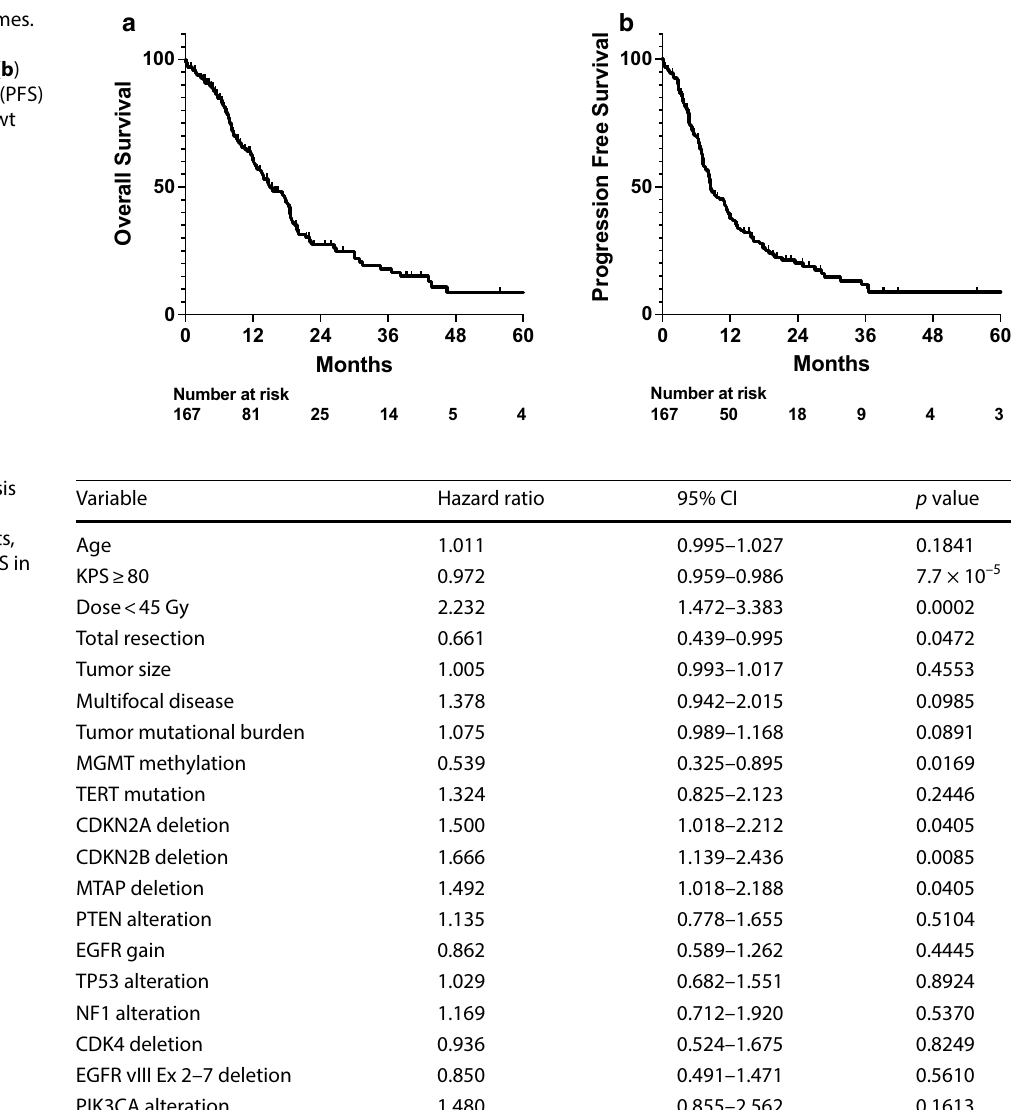
Fig. 1 OS and PFS outcomes. Kaplan–Meyer plot of ( a ) overall survival (OS) and ( b ) progression free survival (PFS) for the full cohort of IDHwt glioblastoma patients